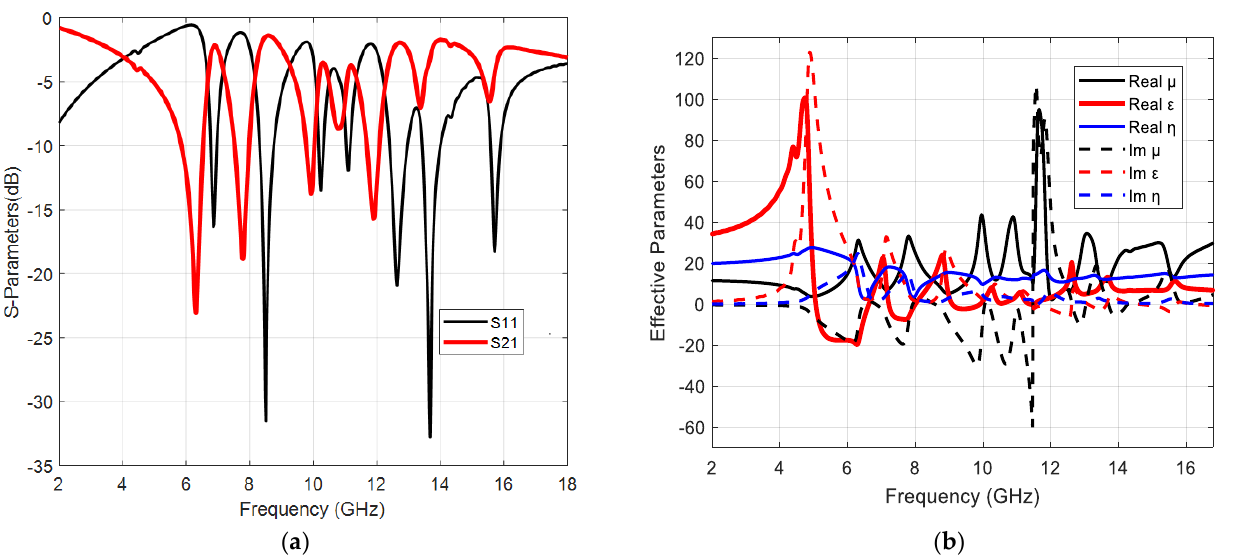
Figure 5. S-parameters and effective parameters of the ISMeTM: ( a ) S-parameters; ( b ) effective parameters.